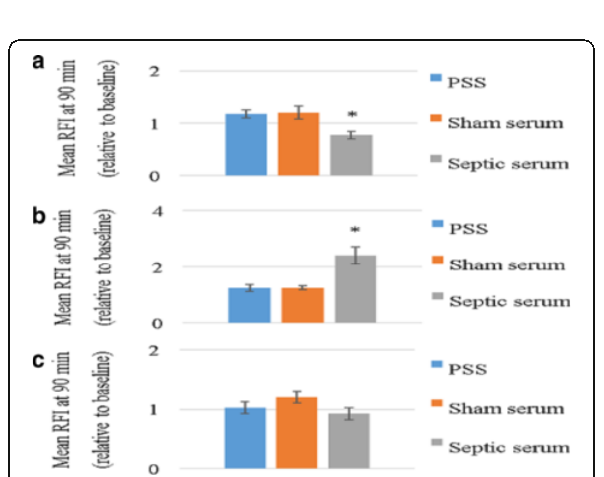
Fig. 61 (abstract A144). a) Mitochondrial membrane potential. Mean tetremethylrhodamine methyl ester RFI at 90 min (relative to baseline) for kidney slices exposed to PSS, sham serum or septic serum. b) Reactive oxygen species generation.